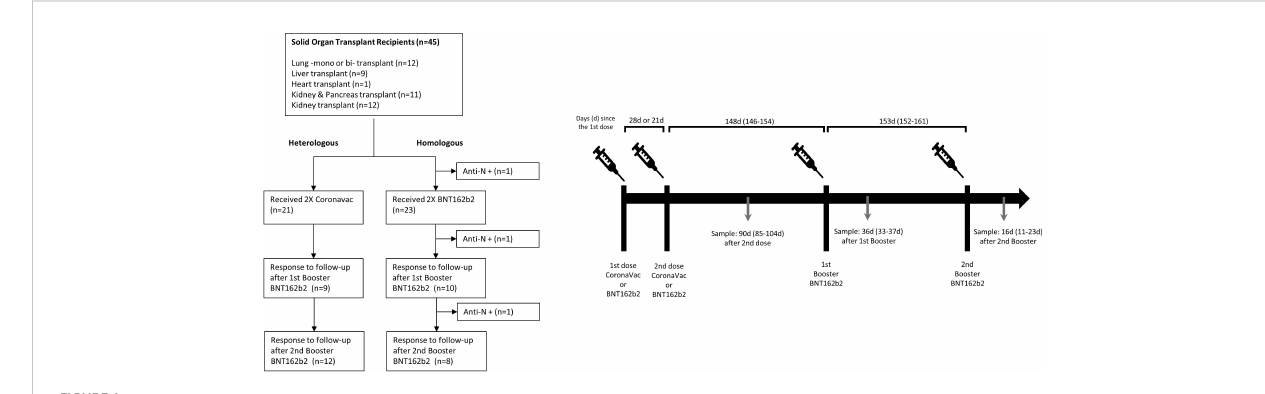
FIGURE 1 Study fl ow-chart and protocol of the observational clinical cohort